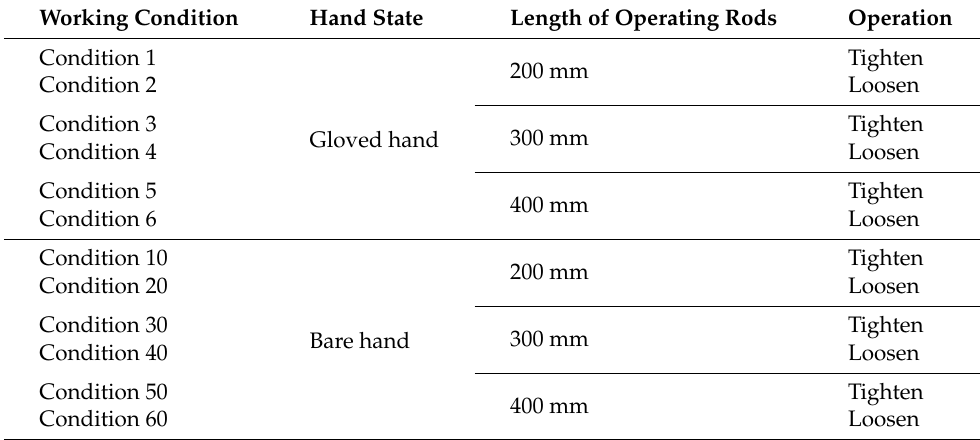
Table 1. Twelve working conditions of the